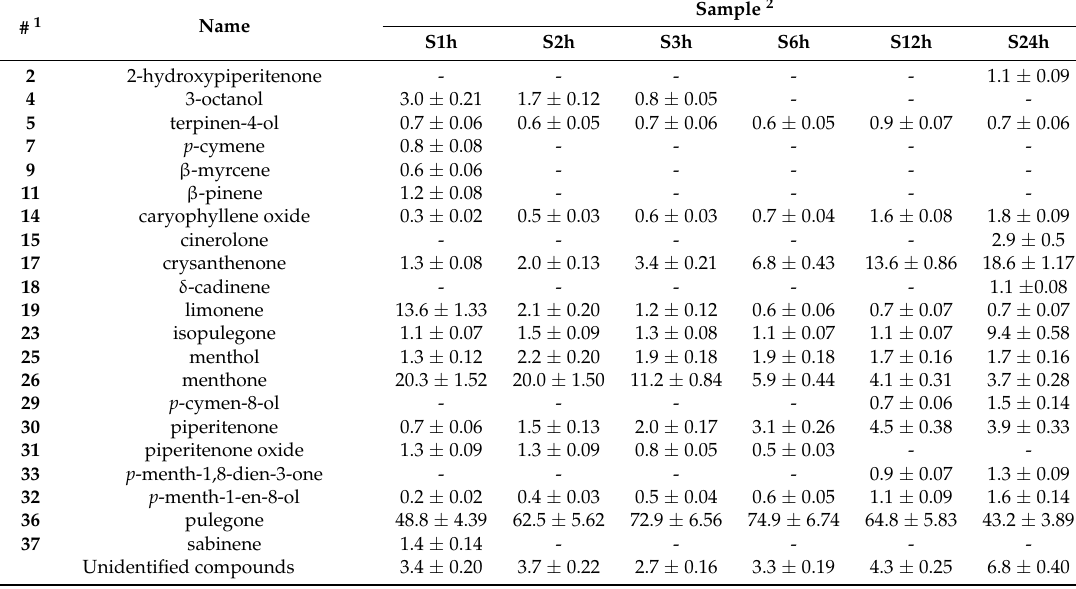
Table 4. Chemical composition (%) of TEOCG extracted in September.